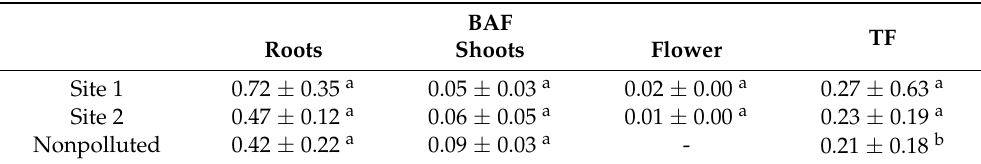
Table 2. Pb bioaccumulation factors (BAF) in roots, shoots, and flower heads and translocation factors (TF) of H. petiolaris plants growing in the experimental sites.